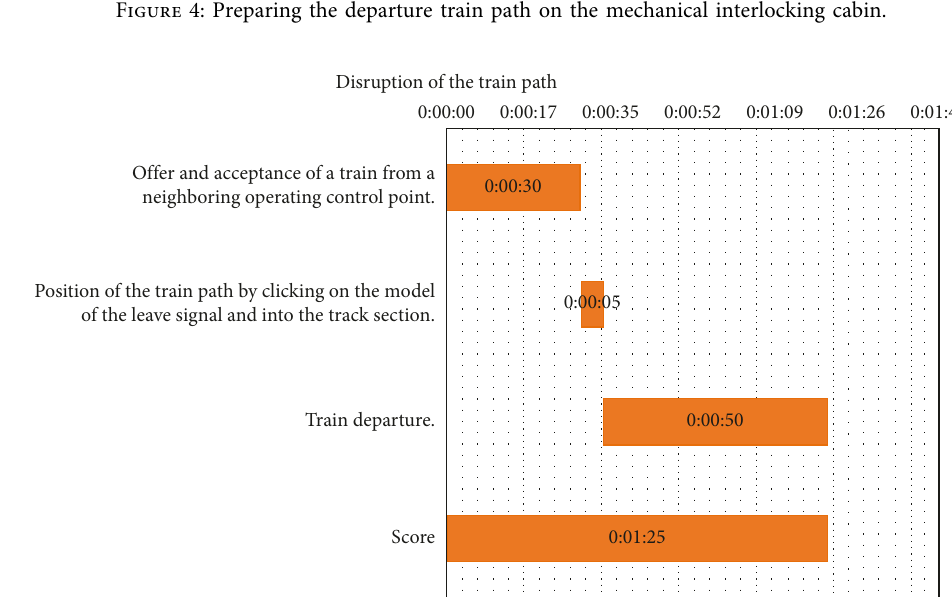
Figure 5: Train path disturbance on the mechanical interlocking cabin.